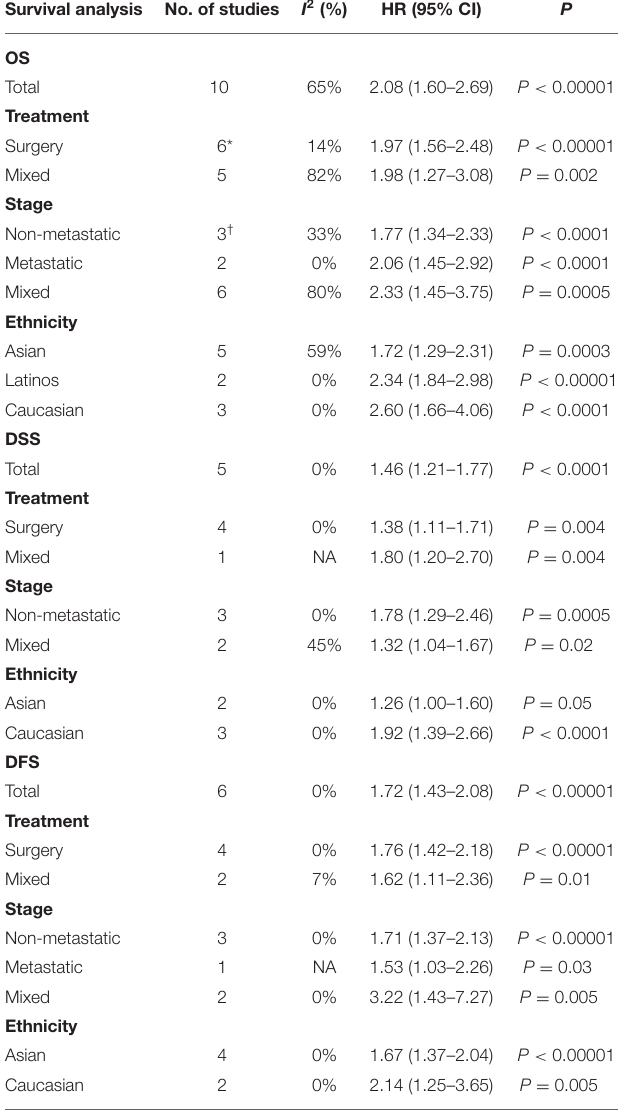
TABLE 2 | Subgroup analysis of the prognostic value of NLR. Survival analysis No. of studies I 2